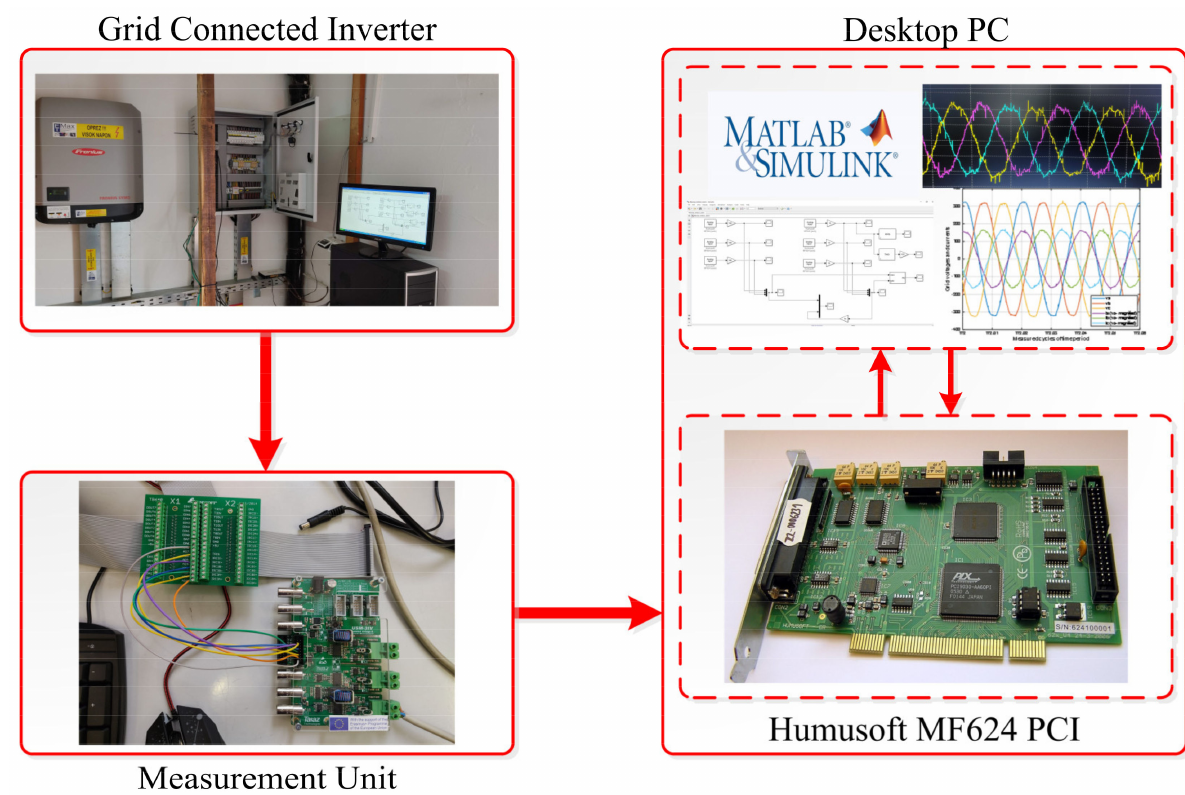
Figure 6. Block diagram of used components for measurement and acquisition